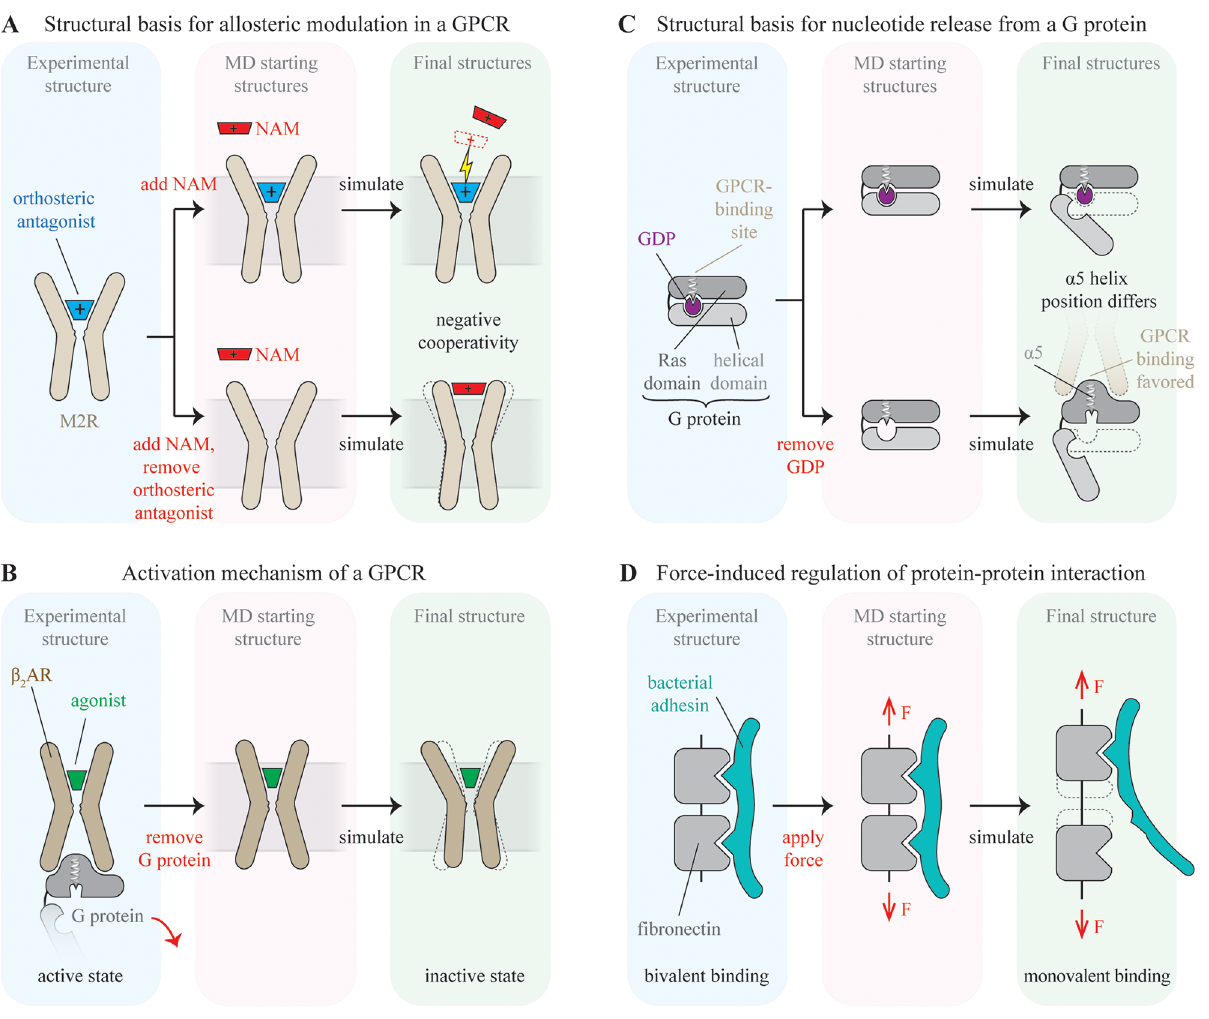
Fig 2. Simulation schematics for case studies. Key perturbations to the experimental structure are indicated in red text. (A) Binding and cooperativity of a negative allosteric modulator (NAM) in the M2 muscarinic receptor (M2R). The binding pose of the NAM and its cooperativity with the orthosteric ligand are probed by performing unguided binding simulations with an unliganded receptor and a receptor with bound orthosteric ligand. Negative cooperativity leads to stronger binding of the NAM to the unliganded M2R. Simulations indicate that cooperativity in this system is due both to direct electrostatic repulsion between cationic ligands and coupled conformational changes of the two binding sites. (B) Activation mechanism of the β 2 -adrenergic receptor ( β 2 AR). Removal of the bound G protein from the active-state, agonist-bound crystal structure of β 2 AR leads to a spontaneous transition to the inactive state in simulation, capturing the activation process in reverse. (C) Mechanism of GPCR-catalyzed nucleotide release from a heterotrimeric G protein. Simulations of a G protein with and without bound guanosine diphosphate (GDP) suggested that nucleotide release from a G protein — which leads to G protein activation — takes place via a previously unexpected mechanism. (D) Force-induced uncoupling of a bacterial adhesin from a fibronectin fragment. MD simulations of a fibronectin – adhesin complex led to the discovery that application of stretching forces to fibronectin reduces its affinity to